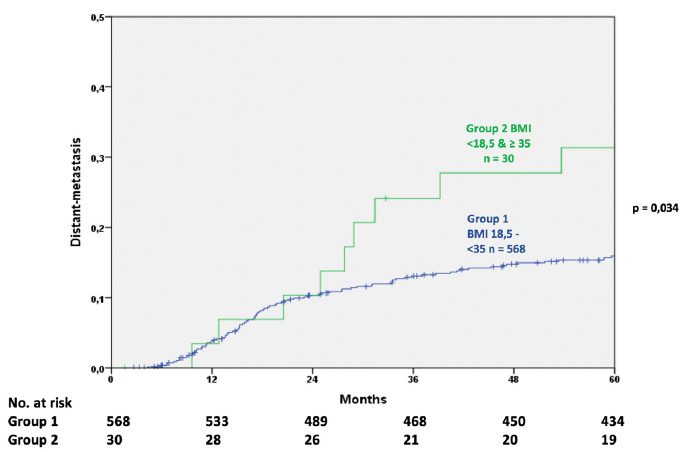
Figure 1. Comparison of distant metastasis after oncological treatment (log rank test). Type of surgery, the preoperative ASA-Score and localisation of the tumour had no significant influence. Individuals with preoperative CEA levels over 5 ng/L had a significantly higher rate of distant metastases and an increased risk to develop distant metastases (Table 5). Table 5. 5-year rate of distant metastases of 598 patients.